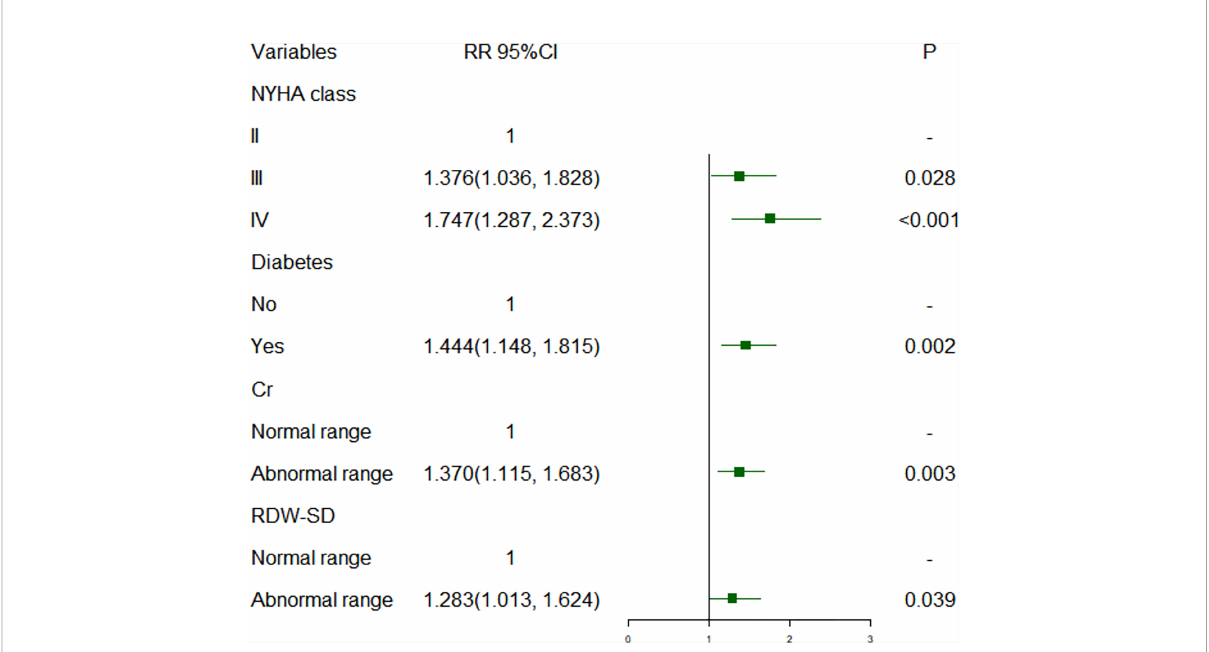
FIGURE 3 Risk factors for readmission within 6 months of heart failure patients: multivariate logistic regression.